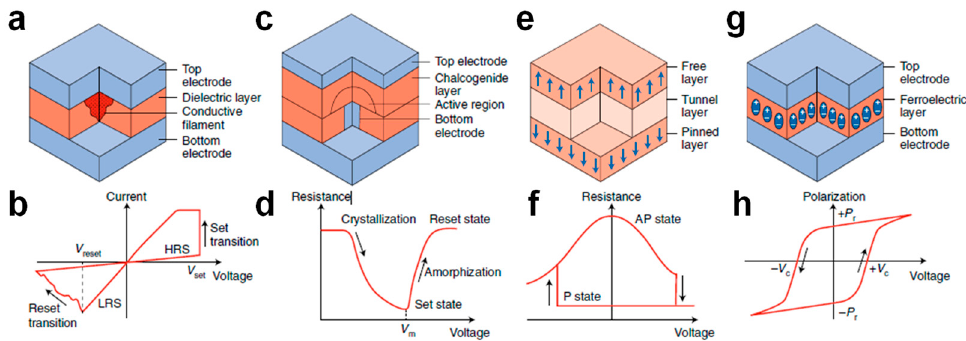
Figure 11. Sketch of the most promising two-terminal memristive devices used in neuromorphic computing applications. ( a ) Structure of resistive switching random access memory (RRAM)